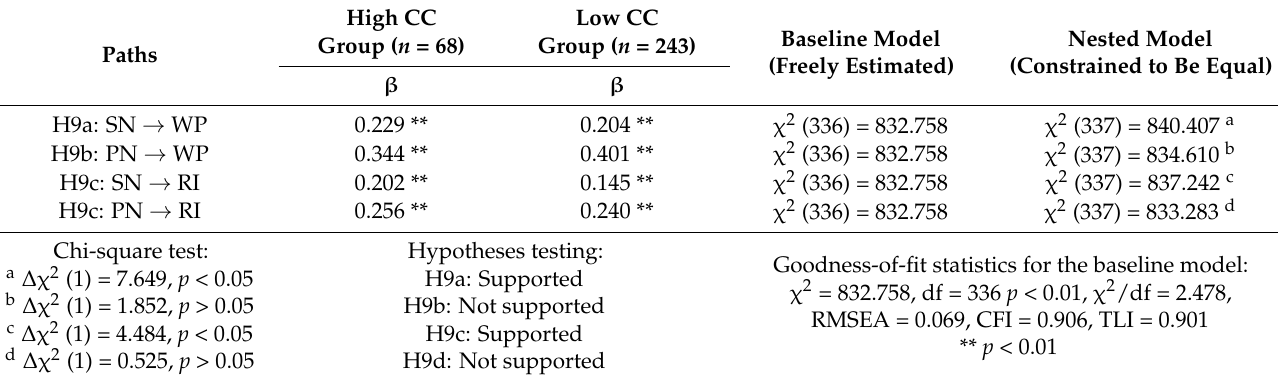
Table 3. Results of invariance test for structural